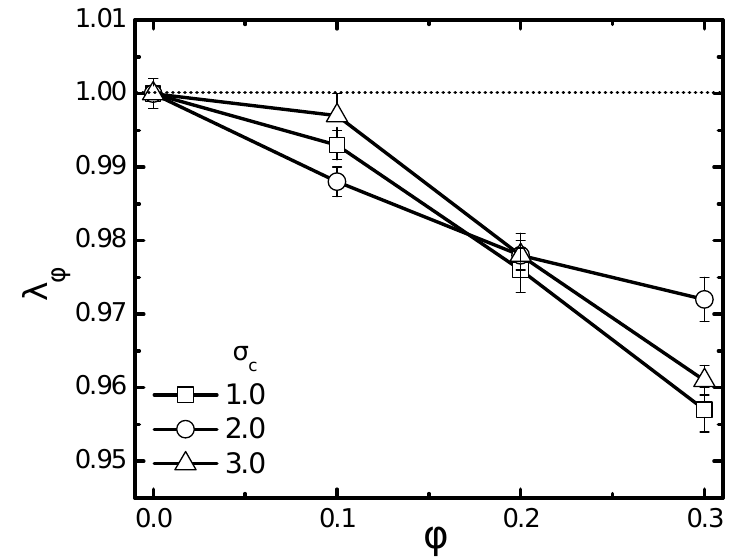
Figure 8. Dependence of scaled gyration radius λ φ on volume fraction φ in a passive bath with three different crowder sizes. The polymer’s rigidity is given as κ = 1.0. Error bars correspond to one standard